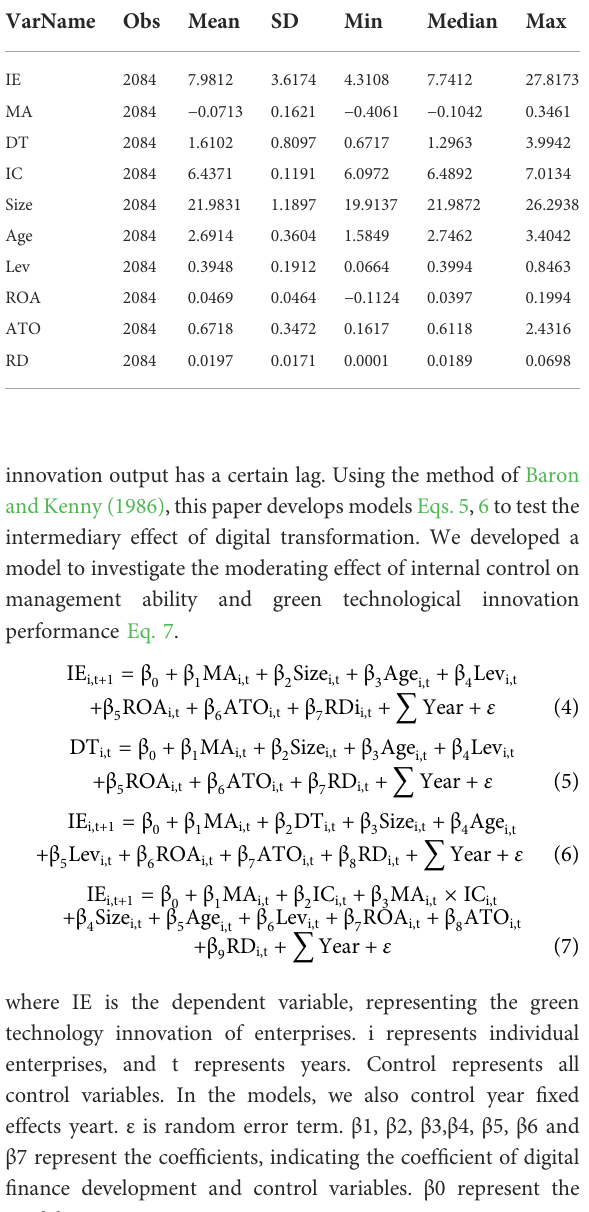
TABLE 2 Descriptive statistics of the main